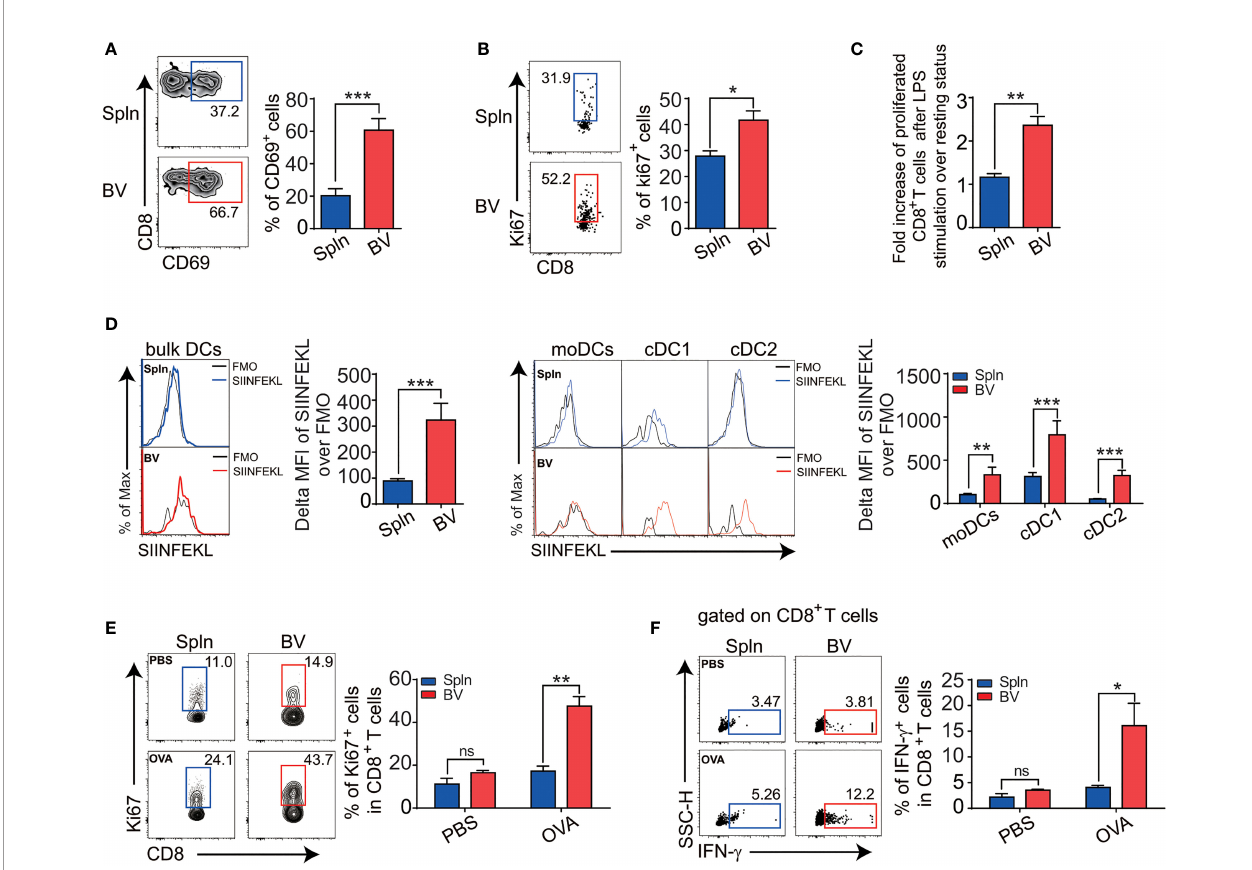
FIGURE 6 | Enhanced CD8 + T activation and cross-presentation in vascular tissues during in fl ammation. Mice were i.v. injected with LPS before FACS analysis of the proportion of CD69 (A) , cell positive for Ki67 (B) , and fold increase of proliferation after LPS stimulation over the steady state (C) in tissue CD8 + T cells. Alternatively, mice were i.v. injected with 1.5 mg OVA with 5 µg LPS for 12 h before the delta MFI of SIINFEKL in bulk DCs and DC subsets from two tissues examined by FACS (D) . WT mice were primed with OVA in the presence of CFA/LPS and restimulated with the same antigen 1 week later before the proliferation (E) , and intracellular IFN-g levels (F) in tissue CD8 + T cells in response to OVA antigen stimulation were compared between spleen and vascular tissues. Shown here are representative plots of experiments with at least three biological replicates. The data are shown as mean ± SEM ( n = 3 – 8 mice) and analyzed using Student ’ s t - test. * p < 0.05; ** p < 0.01; *** p < 0.001. ns, no signi fi cant